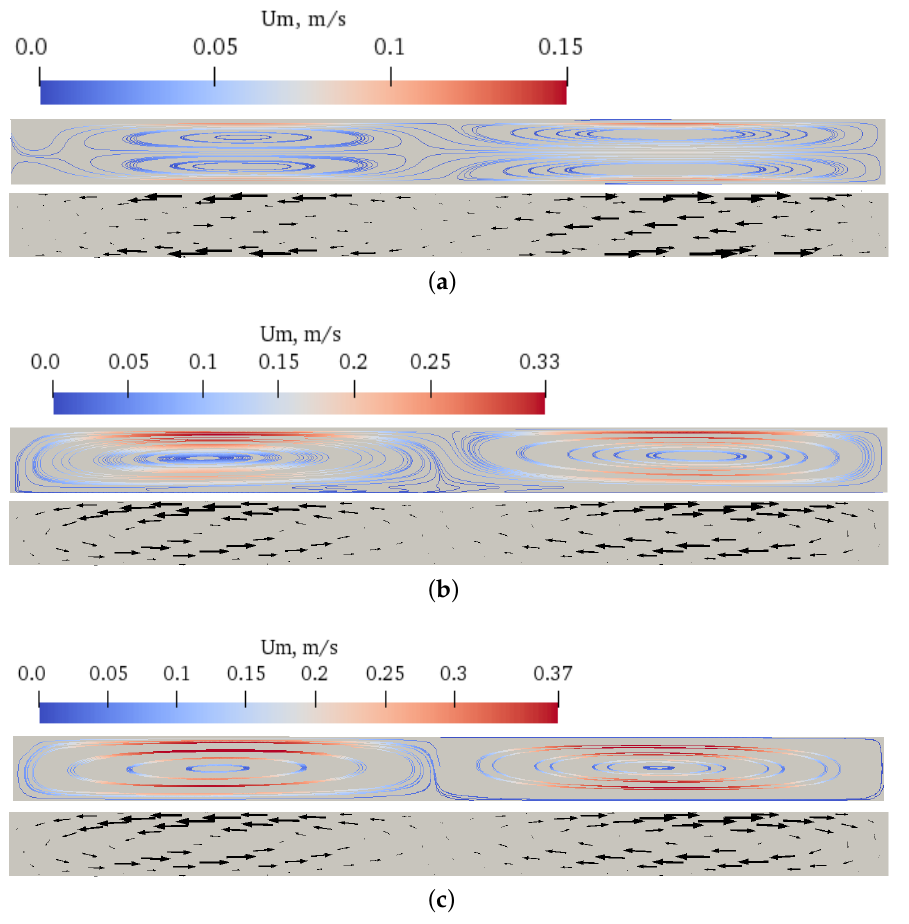
Figure 5. Streamlines, magnitude, and vectors of the streaming velocity U m for f = 20 kHz, cases 1A*,